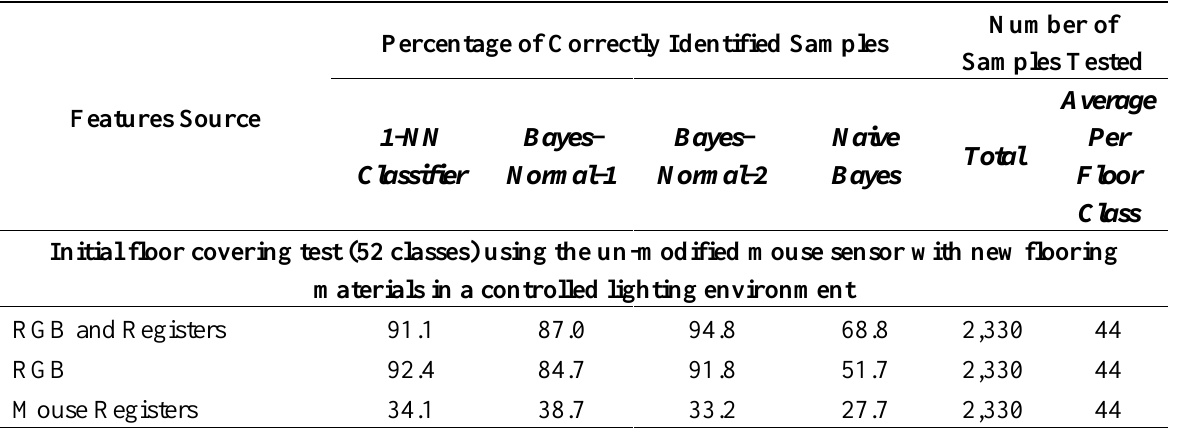
Table 2. Flooring material test results, and room localization test results.